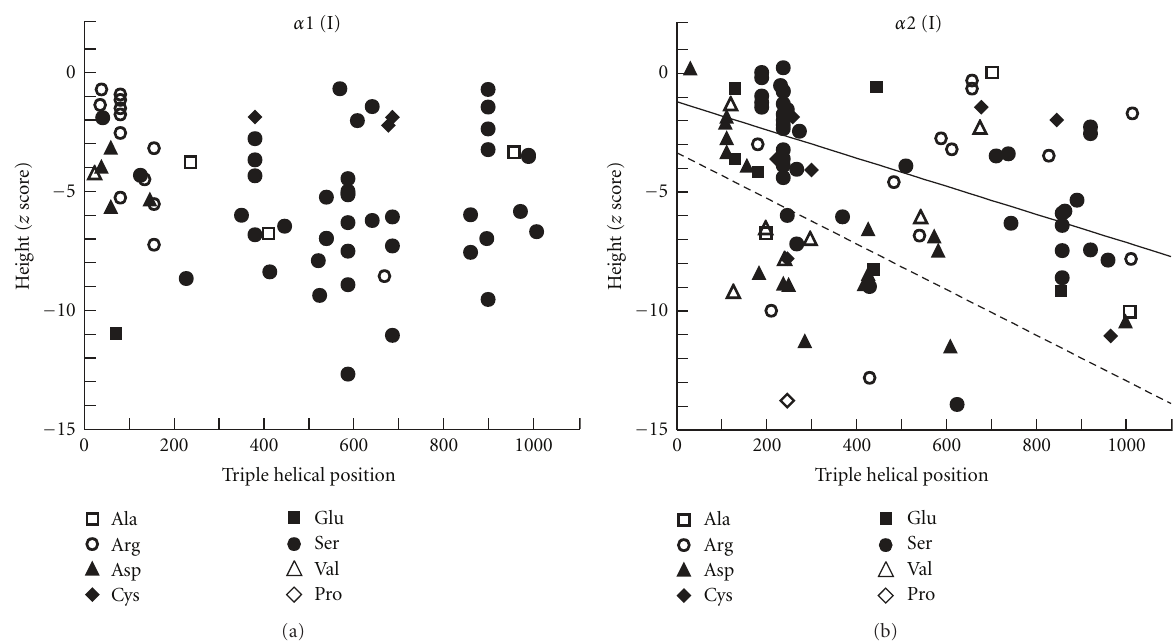
Figure 1: Relationship between the positions of glycine substitutions in the triple helical domain of type I collagen and height z -scores in α 1 chain of collagen I (a) and α 2 chain of collagen I (b). The oblique solid line in B represents the regression line between the position of serine substitutions in α 2 chain of collagen I and height ( r = − 0.73, P < 0.001; Spearman’s rank correlation). The oblique dashed line in (b) represents the regression line between the position of aspartate substitutions in α 2 chain of collagen I and height ( r = − 0.75, P < 0.001). A mutation closer to the carboxy-terminal end of the triple helical domain of alpha 2 chain had a more detrimental e ff ect on height (b). No such correlation was observed in the alpha 1 chain (a), adapted with some modification from [11].